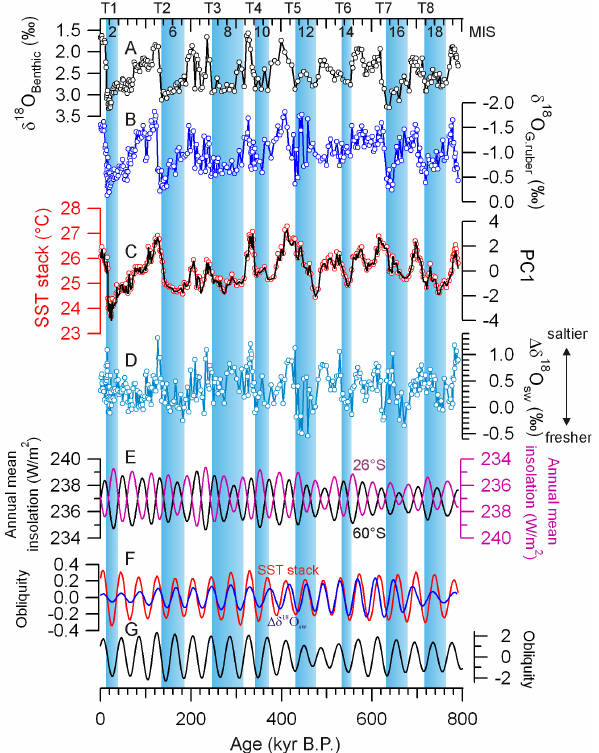
Fig. 2. Comparisons of MD96-2048 records with insolation and Antarctic climate record. (A) δ 18 O of benthic foraminifer P. wuellerstorfi , (B) δ 18 O of planktic foraminifer G. ruber , 0 (C) stacked record of Mg/Ca, U K , and TEX H SSTs (red line) 37 86 and first order of Principal Component (PC1, black line) derived from EOF analysis, (D) reconstructed 1δ 18 O sw (a proxy of re- gional sea surface salinity), (E) annual mean insolation at 60 ◦ S or 60 ◦ N (black) and 26 ◦ S (purple) calculated according to Berger and Loutre (1991), (F) obliquity components (frequency 1/41000; bandwidth: 5e-06) of SST stack (red) and 1δ 18 O sw (blue) and (G) obliquity components (frequency 1/41000; bandwidth: 5e-06) of atmospheric temperatures of EPICA Dome Concordia (EDC), Antarctica (Jouzel et al., 2007). T indicates terminations and num- bers indicate marine isotopic stages